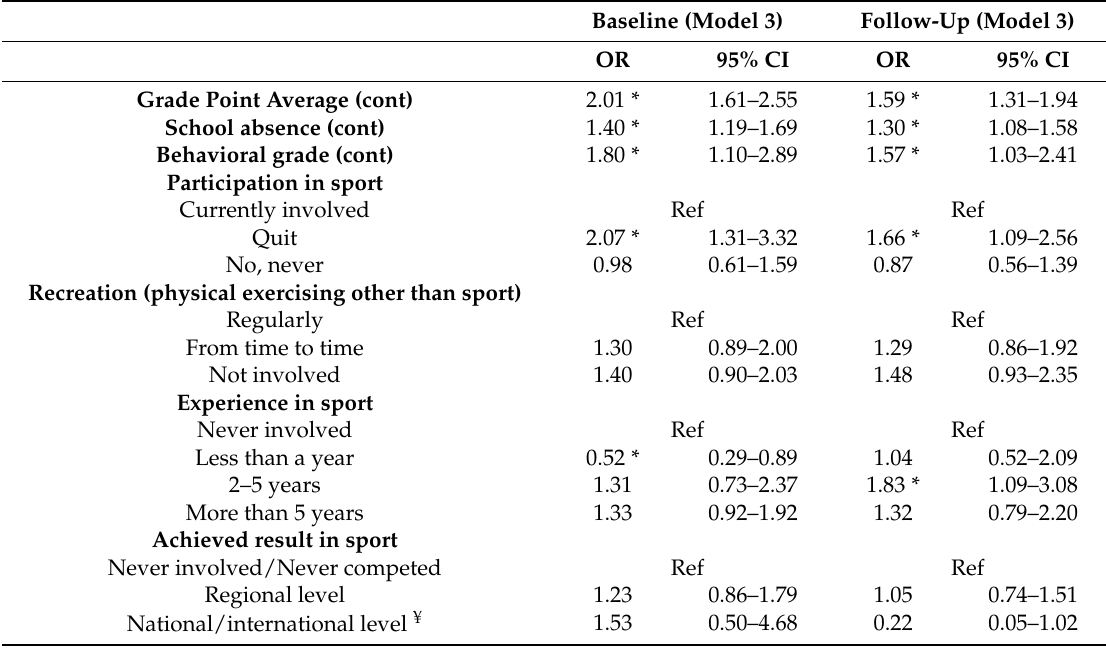
Table 1. Correlates of smoking at baseline and follow-up for 265 (41%) and 312 (49%) being smokers at baseline and follow-up,